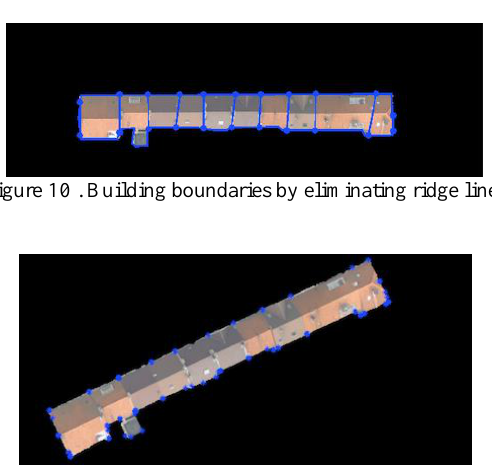
Figure 9 . Candidate inner boundaries